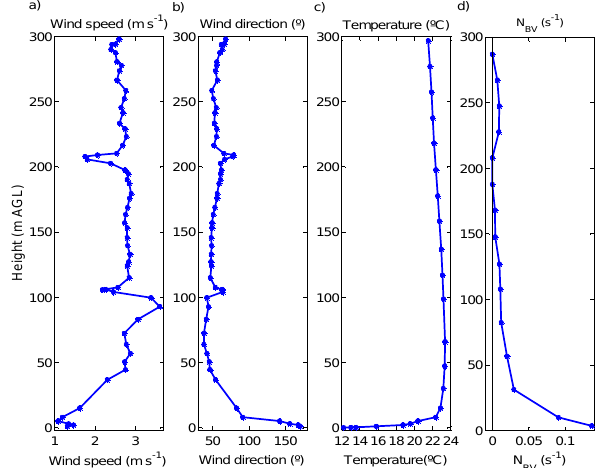
Figure 8. Vertical profiles considering combinations of measure- ments from 8m tower measurements (from 1 to 8ma.g.l.), 60m tower measurements (15ma.g.l.) and the tethered balloon’s de- scent measurements (from 30m up to 300ma.g.l.) approximately at 19:55UTC. a) Wind speed (ms − 1 ). (b) Wind direction ( ◦ ). (c) Tem- perature ( ◦ C). (d) Brunt Väisälä frequency (N BV ) (s − 1 ).